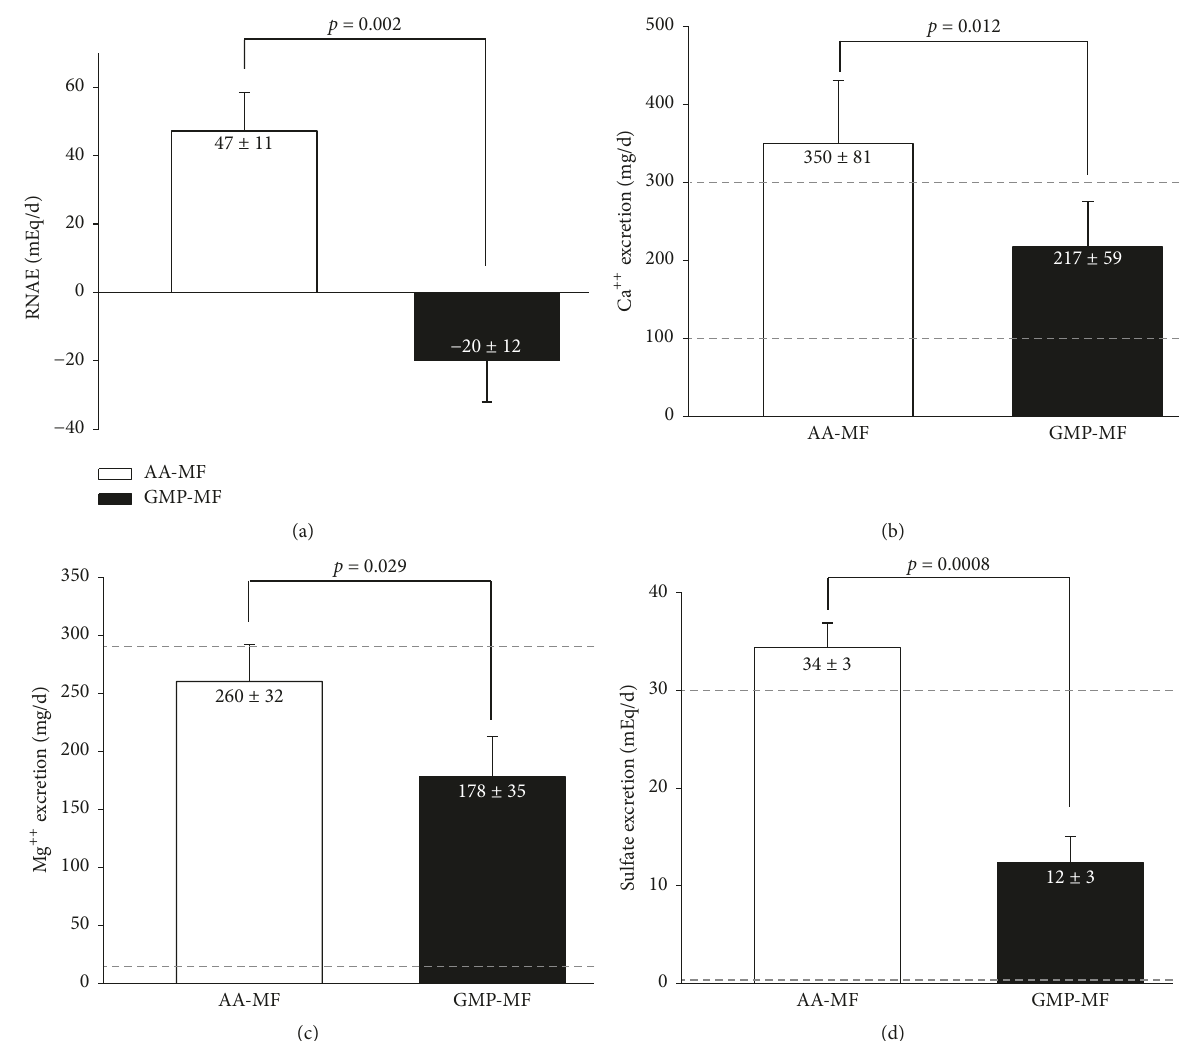
Figure 2: Renal net acid excretion (a), urinary calcium excretion (b), urinary magnesium excretion (c), and urinary sulfate excretion (d), based on 24-hr urine collections in participants with PKU who consumed AA-MF or GMP-MF, n = 8. Values are means ± SE. The dashed lines (b, c, d) represent the reference range for urinary calcium excretion (100–300 mg/d), magnesium excretion (12–293 mg/d), and urinary sulfate excretion (0–30 mEq/d). Results indicate significant increases in renal net acid excretion ( p = 0.002), urinary calcium ( p = 0.012), magnesium ( p = 0.029), and sulfate ( p = 0.0008) excretion with AA-MF compared to GMP-MF. AA-MF, amino acid medical foods; GMP- MF, glycomacropeptide medical